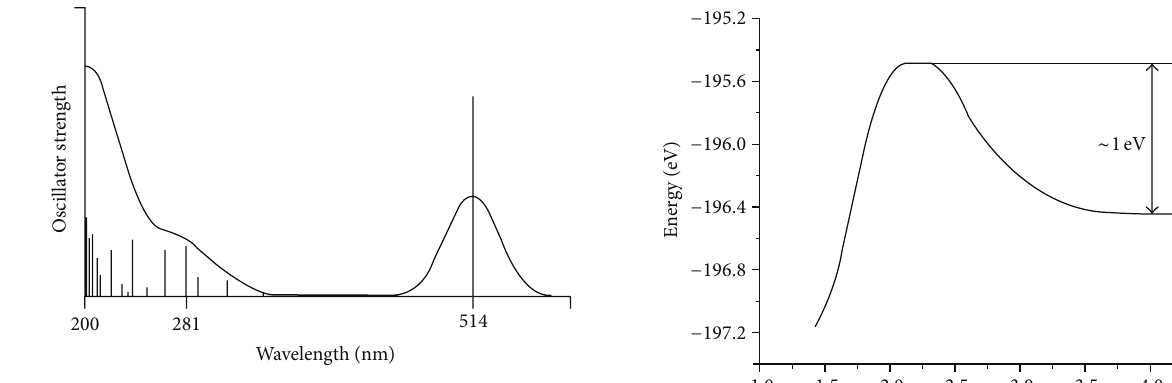
Figure 4: The absorption spectrum of the merocyanine.